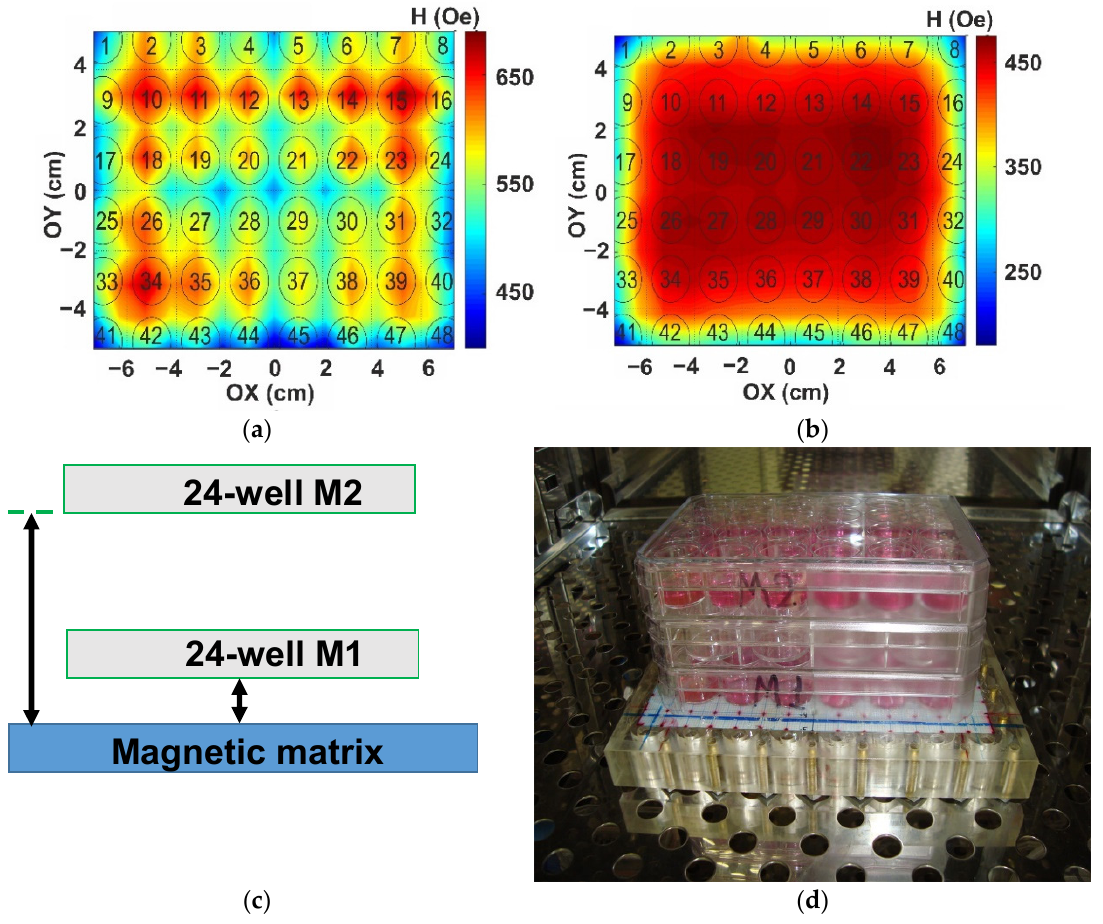
Figure 2. Constant magnetic field distribution of the external field created by the magnetic system in XY plane (see also Figure 1) at Z = 1.0 cm ( a ) and Z = 2.0 cm ( b ). Description of the distances M1 and M2 selected for cell experiments on the basis of magnetic measurements ( c ). Arrangement of the cellular experiments with the use of plates’ stack in the CO 2 incubator ( d ).